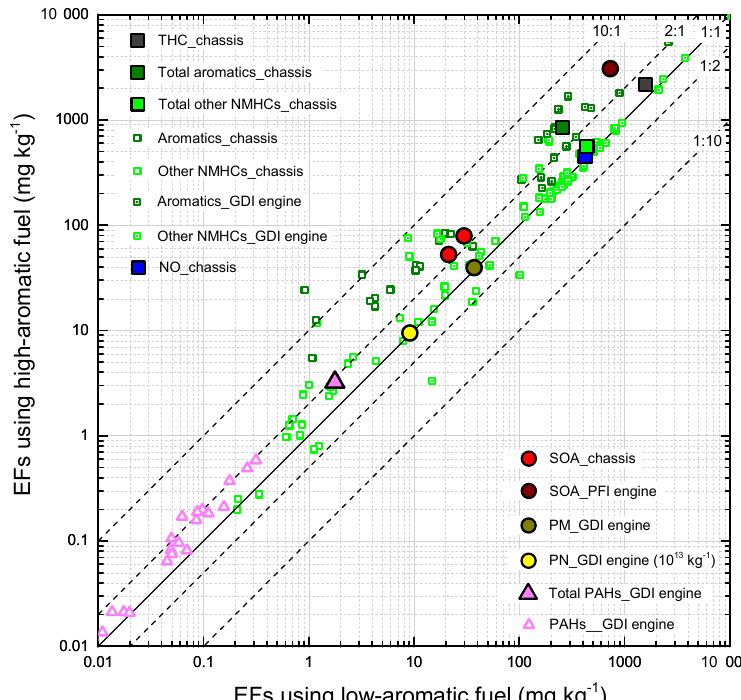
Figure 4. Comparison of emission factors (EFs) of gas and particle species using high-aromatic fuel (F3 fuel) to those using low-aromatic fuel (F2 fuel). The total hydrocarbons (THC) were measured using a vehicle emissions testing system (HORIBA, Ltd.), and the total aromatics and non-methane hydrocarbons (NMHCs) were measured by offline GC-MS. The solid black line denotes where the ratio of EFs using aromatic-rich fuel over aromatic-poor fuel is 1 : 1, and dashed lines show the ratios of 10 : 1, 2 : 1, 1 : 2, and 1 : 10. Note that the PAH and VOC data for the GDI engine were measured before the three-way catalyst (TWC). Values in the figure can be found in Table